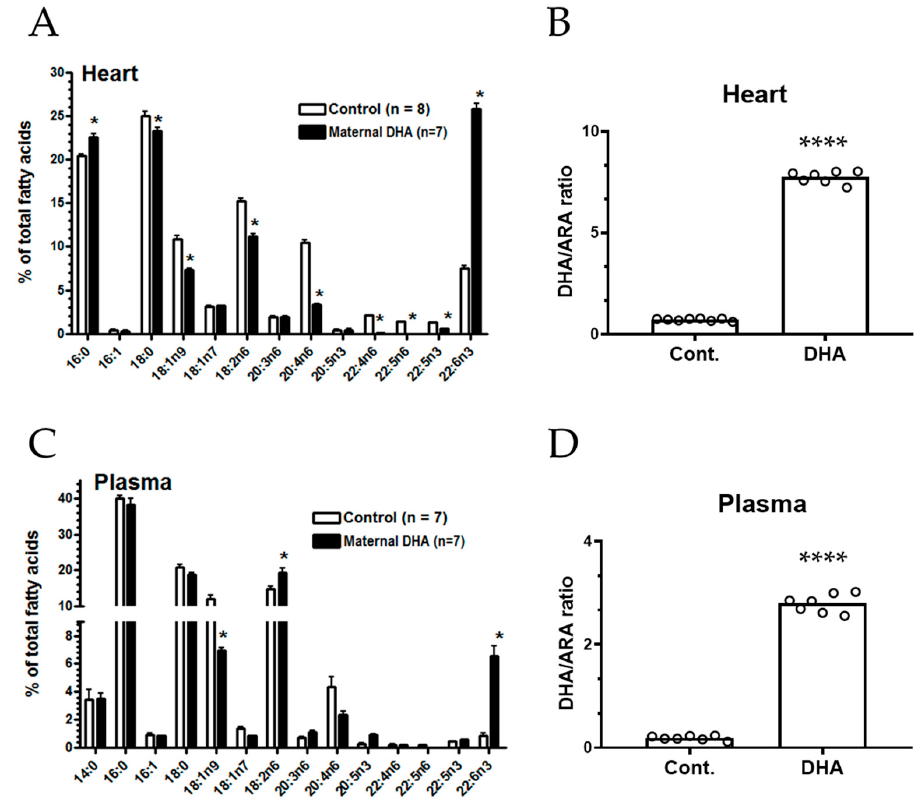
Figure 5. Maternal DHA intervention alters the FA composition in offspring heart and plasma. ( A , C ): FA composition from the heart and plasma in developing pups nursed by mothers fed a control and 1% DHA diet, respectively. ( B , D ): Ratios of DHA/ARA in the heart and plasma, respectively. FA composition was reported as percent of total FA content (g per 100 g). Each value represents the mean ± SEM of eight and seven pups from control and 1% DHA diet groups, respectively. Analysis of FA using one way-ANOVA indicated significance between control and 1% DHA diet group. * p < 0.05. Analysis of DHA/ARA ratios using two-tail unpaired t-test indicated significance between DHA group and controls. **** p < 0.0001.